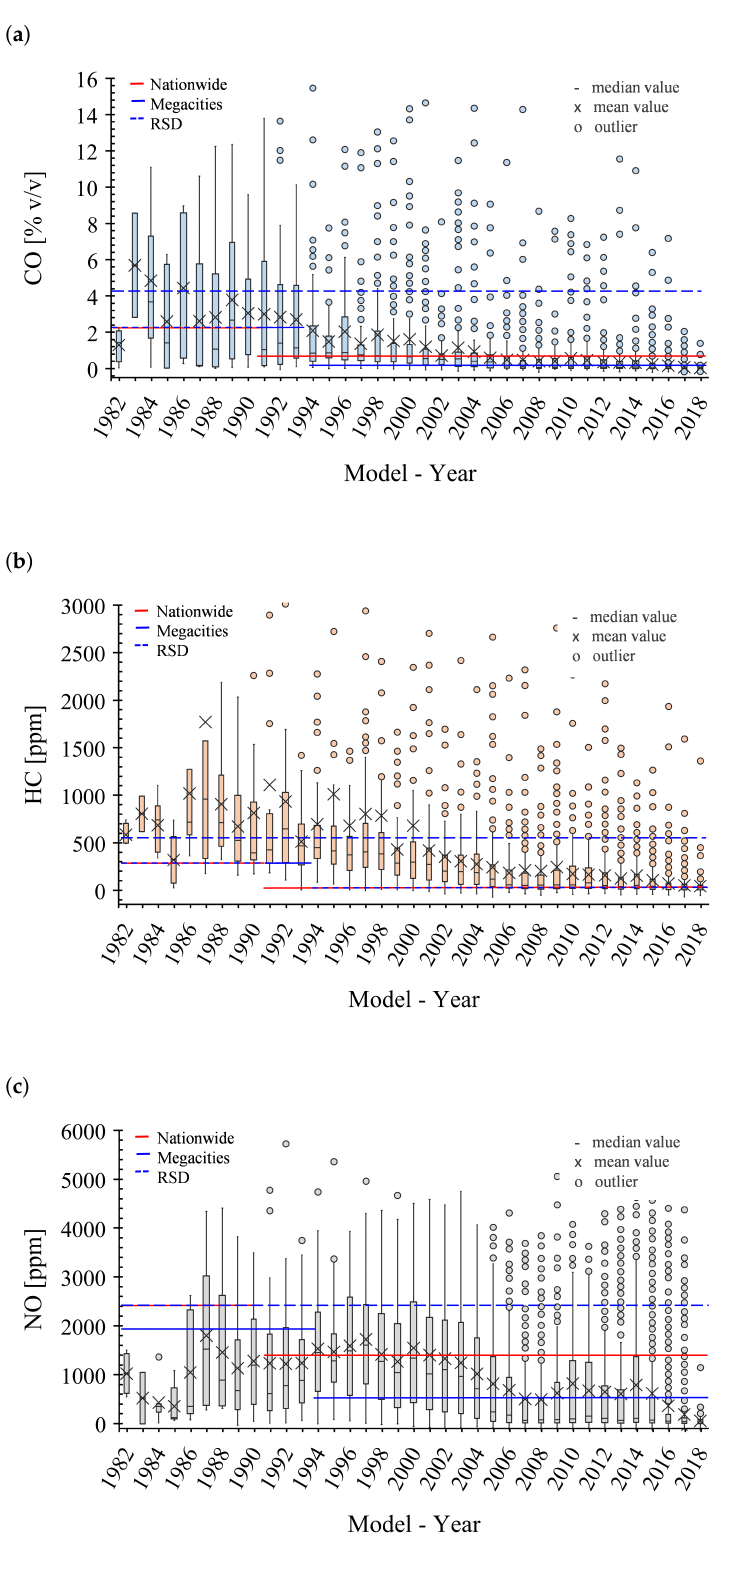
Figure 4. Boxplots of the ( a ) CO, ( b ) HC (hexane equivalent), and ( c ) NO tailpipe concentrations, per model-year, measured during the 2018 MMA RDS monitoring